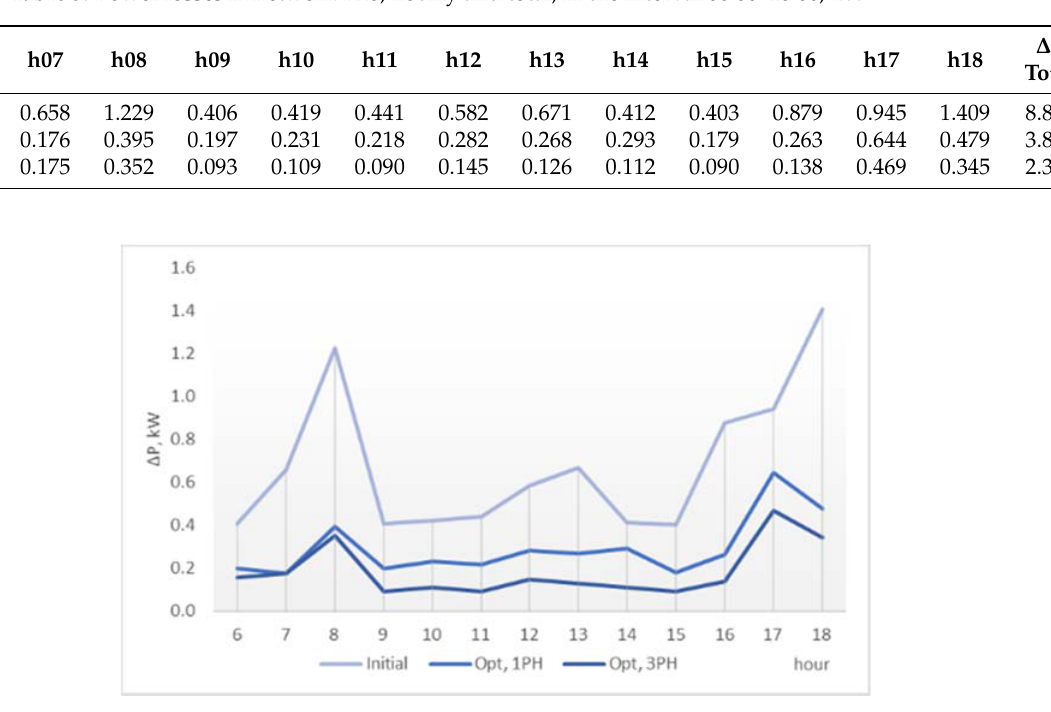
Figure 10. Hourly losses in network R28.